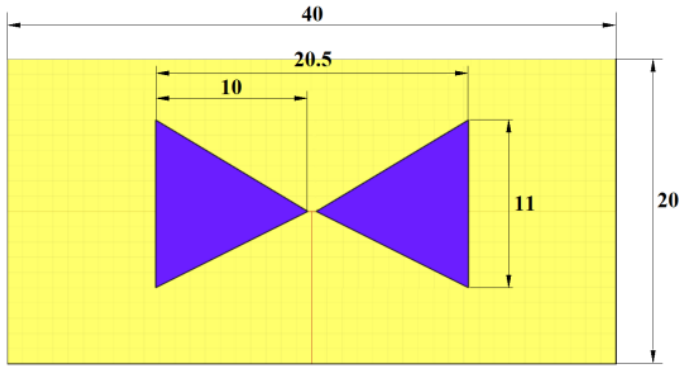
Figure 1. TBA model: Antenna substrate (yellow) and antenna arms (blue). All dimensions are in mm.